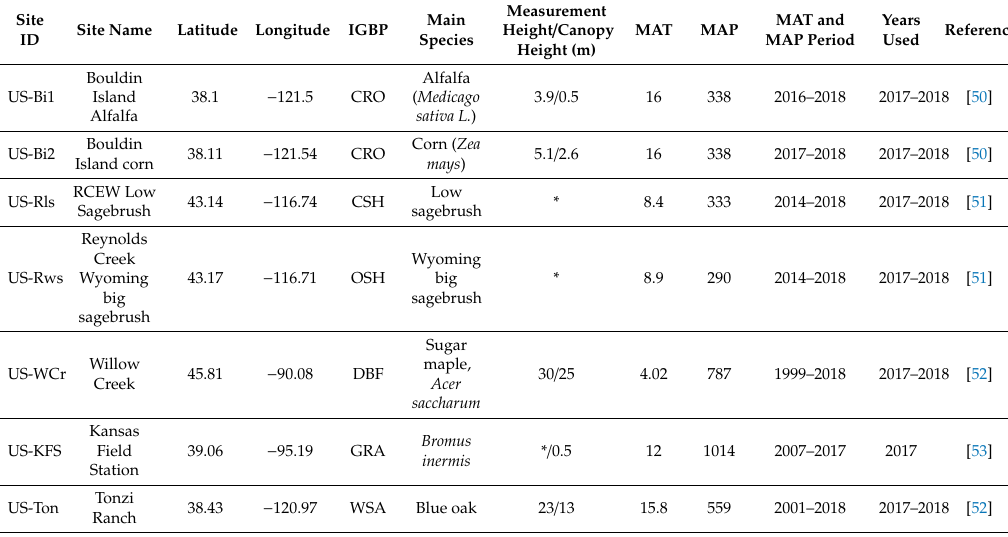
Figure 1. Geographical location of AmeriFlux sites in this study. Table 1. List of AmeriFlux eddy covariance tower sites used in this study.